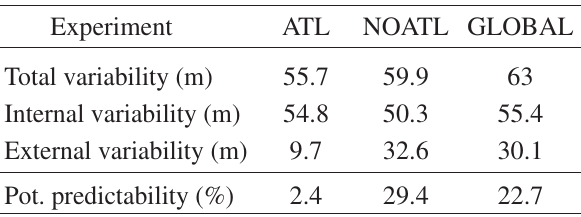
Table I. Regional-averaged values of the total, internal and forced variability for the three experiments ATL, NOATL and GLOBAL. The average is over the PNA (Pacific-North-America) region (145 ° E/80 ° W and 30/80 ° N). Last raw gives the values of potential pre- dictability. The 99% (or 95%) significance level is reached when potential predictability is 6.4% (or 4.3%) for ATL and NOATL, and 6.2% (or 4.2%)